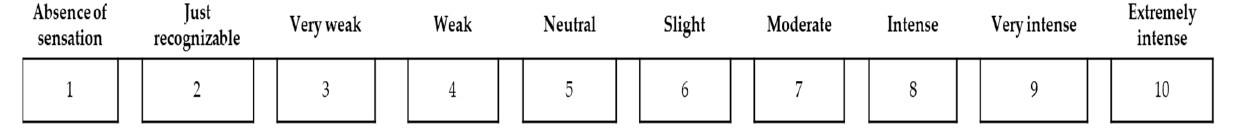
Figure 2. Scores of intensity of each descriptor . Table 1. Descriptive attributes and their definitions adapted from UNE-EN-ISO